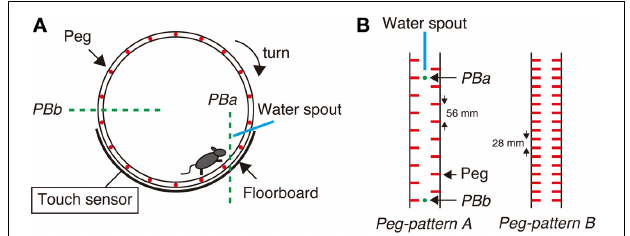
FIGURE 1 | Step-Wheel System. (A) The wheel was driven by a motor, turning clockwise at a constant speed. The infrared photobeams (green dot lines) and an electric touch sensor were used for detecting mouse behaviors. Photobeam a ( PBa ) was used for detecting a mouse running in the vicinity of the spout; Photobeam b ( PBb ) was used for detecting the mouse when it was on the most downstream of the wheel. The touch sensor detected foot touches when the mouse fell down to the floorboard. (B) Two peg patterns used in this study. Peg-pattern A was designed for mice to run in the “walk” gait. Peg-pattern B was designed to have an easier and simpler pattern with twice as many pegs as peg-pattern A . The water spout and two photobeams ( PBa and PBb ) were set between the right and left